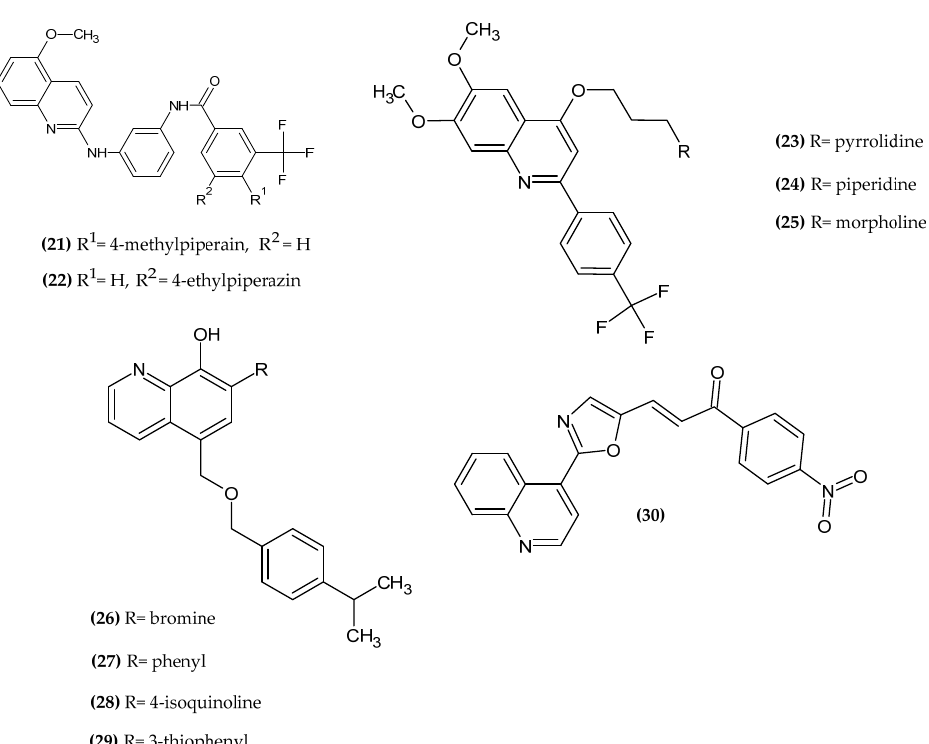
Figure 5. Quinoline derivatives with anti-melanoma activity.